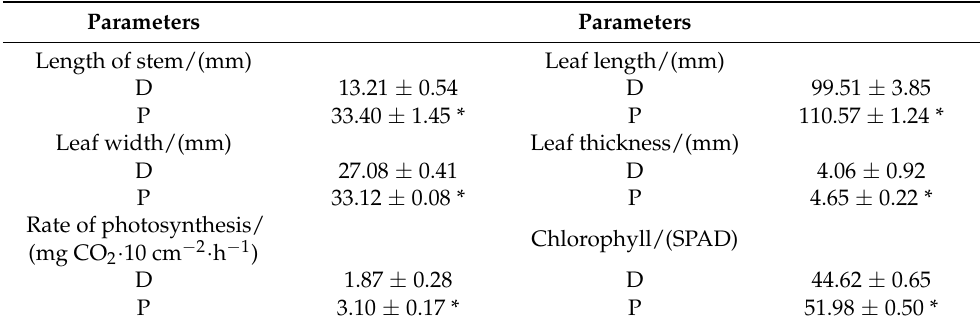
Table 1. Effects of prochloraz on the vegetative growth of decline-diseased bayberry trees. Parameters